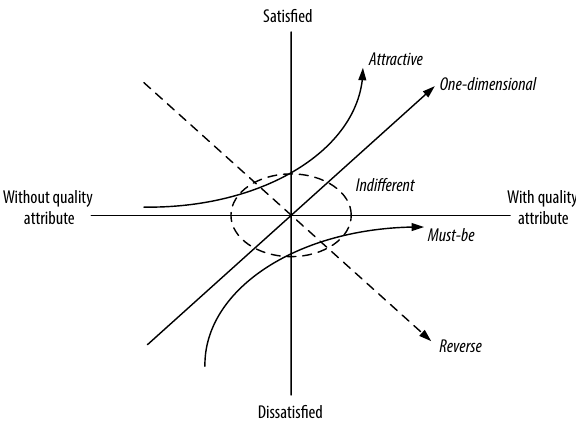
Fig. 2. Kano two-dimensional quality model